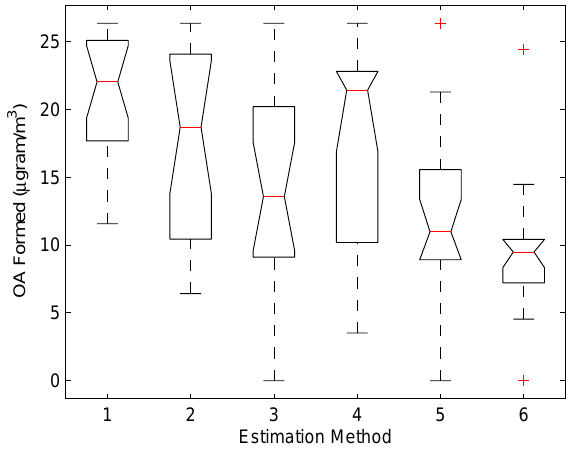
Fig. 5. Sub-cooled liquid vapour pressures in Pa at 298K. Symbols: × KEMS; m Moller with Nannoolal T b ; l Moller with Joback T b ; (cid:3) Myrdal and Yalkowsky with Stein and Brown T Yalkowsky with Joback T b ; M Nannoolal with Nannoolal T b ; N Nannoolal with Joback T b .